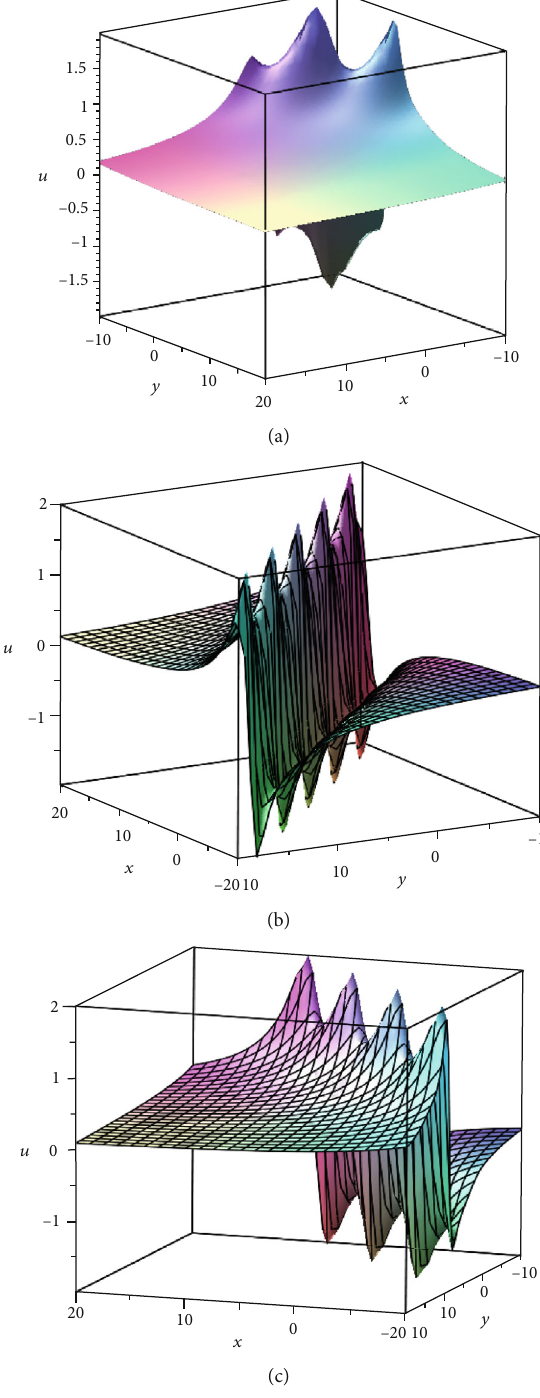
Figure 10: Spatiotemporal structure of solution (47) with the parameter selections: (a) t = 0 , a 5 = 1 , a 6 = 1 , a 7 = 1 , p 1 = 1 , b 1 = 1 , δ = 1 , and δ = 1 ; (b) t = 10 , a = 1 , a = 1 , a = 1 , p = 1 , b = 1 , δ = 1 6 5 6 7 1 1 1 = 1 ; (c) a = 1 , a = 1 , a = 1 , p = 1 , b = 1 , δ = 1 , and δ = 1 1 , and δ 6 5 6 7 1 1 6 1 With the help of Maple, the three-dimensional dynamic graphs are drawn as Figure 10. We can fi nd that lump waves and periodic waves interact with each other and keep moving in the opposite direction.